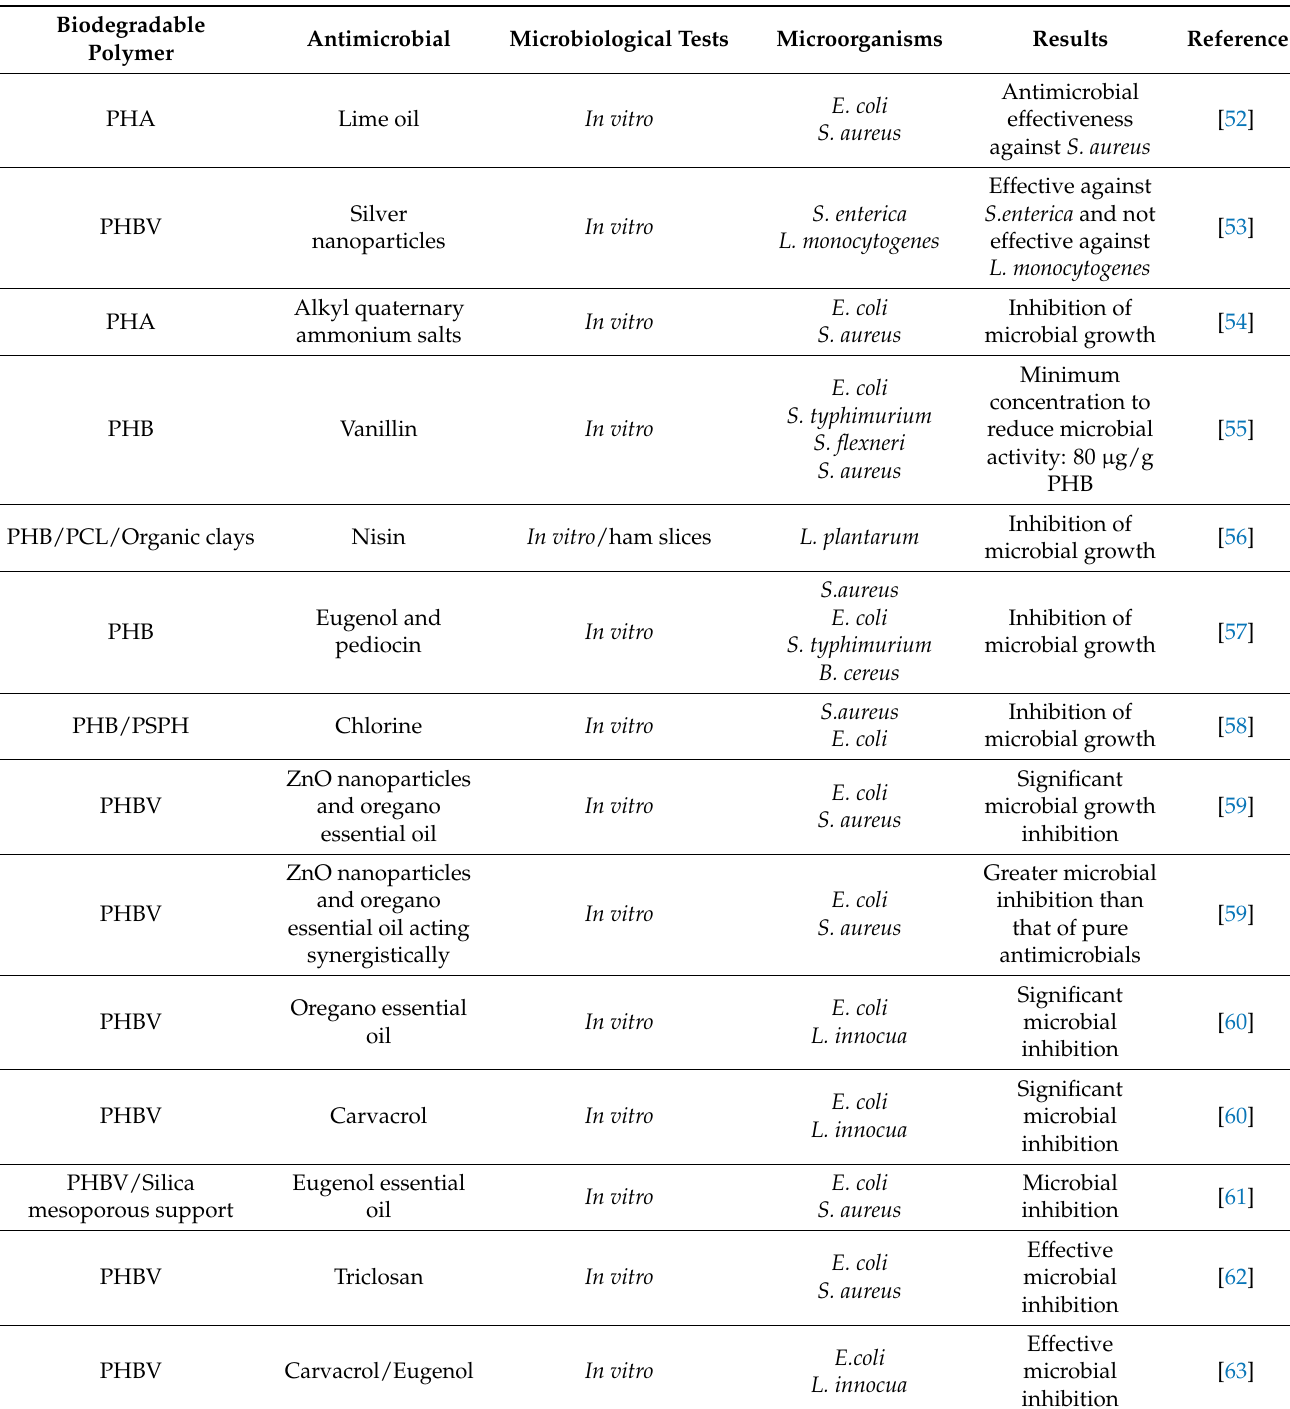
Table 3. Different studies on antimicrobial films based on biopolymers obtained from microorganisms (PHA, PHB and